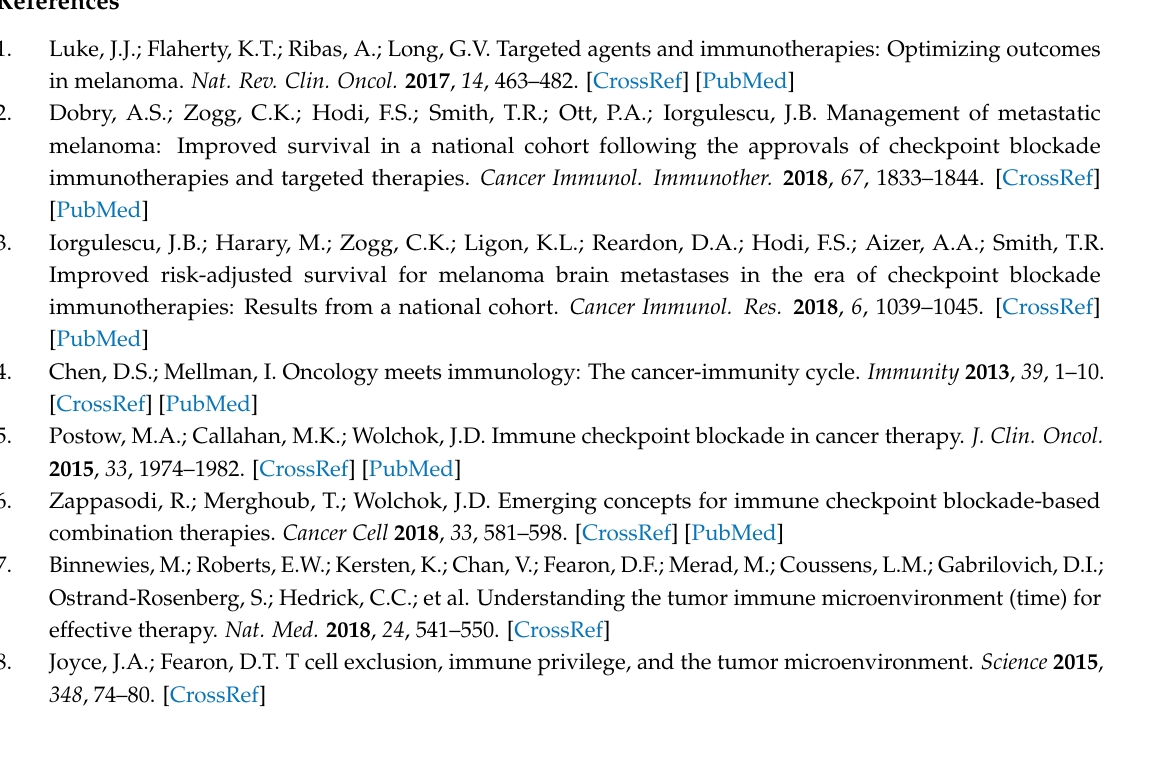
Table S1: Quantification of peptides per conjugate, Figure S1: mouse specific Ab:Ag specificity, Figure S2: T cell responses after Ab:Trp1